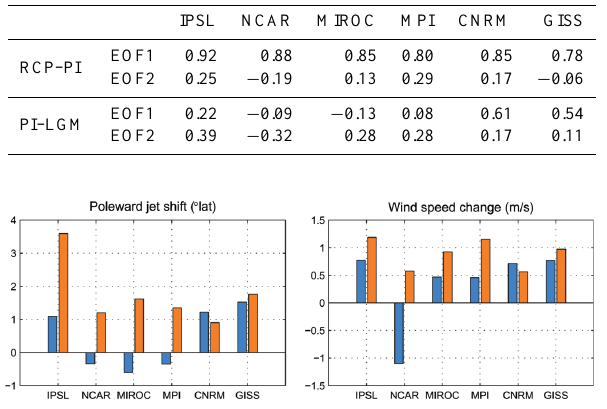
Fig. 3. Left panel: jet stream poleward shift ( ◦ of latitude) and right panel: wind speed maximum anomaly (ms − 1 ), PI–LGM (in blue) and RCP–PI (in red).